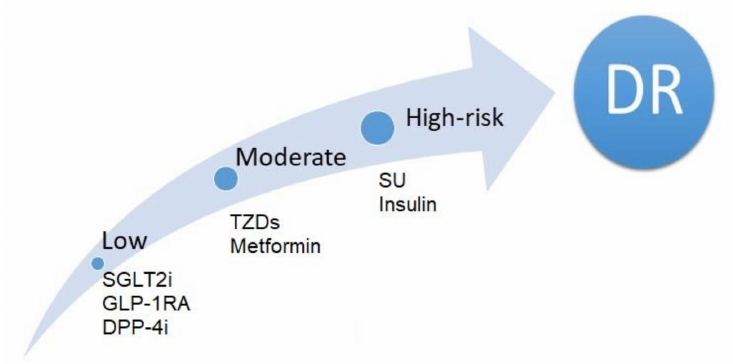
Figure 4. Comparisons of risk of diabetic retinopathy events associated with glucose lowering drugs in patients with DM. DR-diabetic retinopathy, SGLT2i- Sodium-dependent glucose trans- porters, GLP1- glucagon-like peptide 1,DPP4- dipeptidyl peptidase-4,TZD- thiazolidinediones, SU-